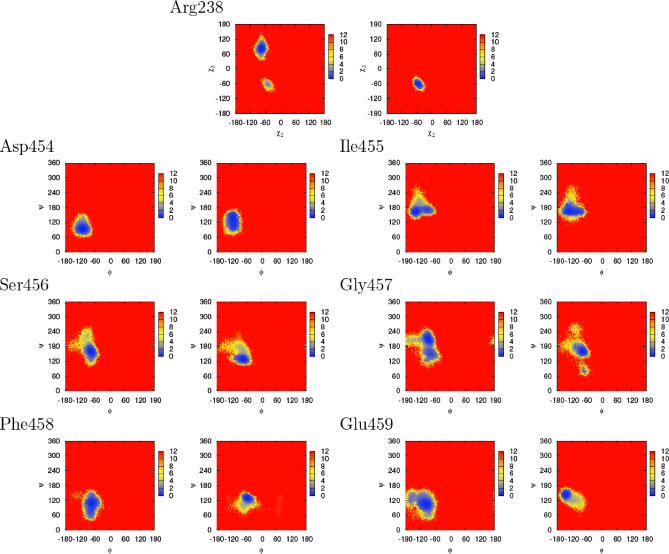
Free-Energy Map (in kcal/mol) for the Conformations of Arg238 Sidechain (χ2, χ3) and Main Chains (ϕ, ψ) in the Switch II Region (454–459), Calculated Using Equations 5 and 6
For each residue, map on the left is for the 1FMW:ATP state and map on the right is for the 1VOM:ATP state.